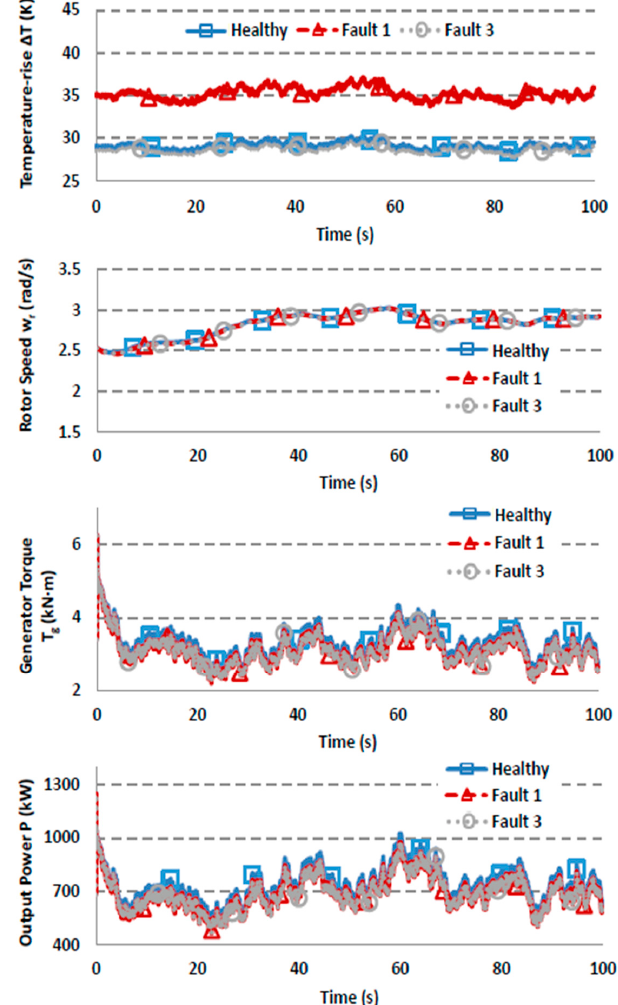
Figure 7. Simulation results of a WT in three states: healthy, with Faults 1 and 3.